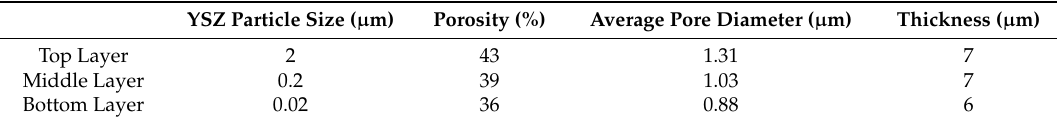
Figure 1. Cross-section image of the cell with functionally graded tri-layer LSM-YSZ composite cathode. Table 2. Structural characteristics of the functionally graded tri-layer LSM-YSZ composite cathode.